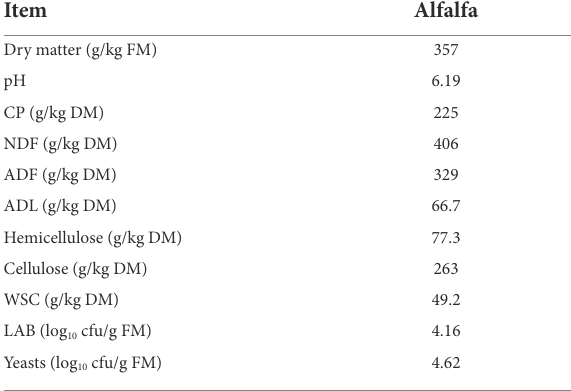
TABLE 1 Chemical composition and microbial counts of fresh